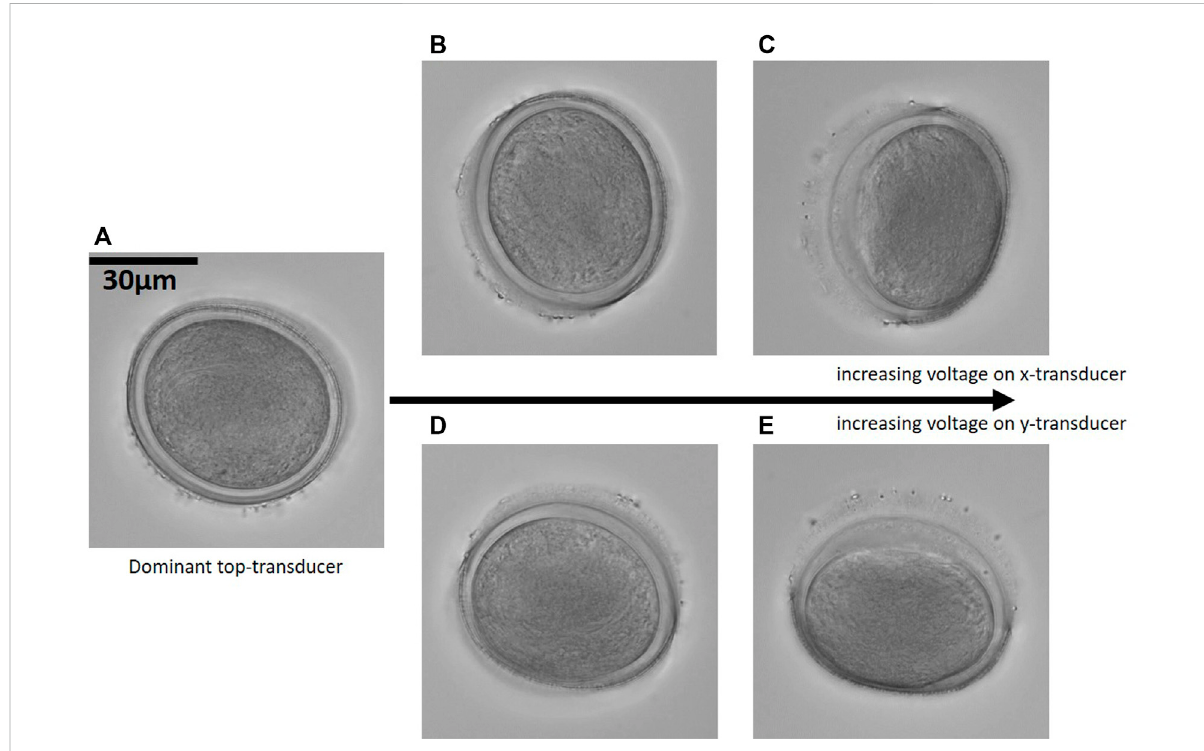
FIGURE 4 Transient reorientation: By adjusting the relative voltages of the three orthogonal transducers a pollen grain from Sansevieria trifasciata is transiently rotated. In (A) the particle aligns to the nodal planes from the top-transducer, in (B) and (C) the voltage on the x-transducer is increased and the particle aligns, within the top nodal plane, to an orientation up towards 90 ° relative to the orientation in (A) . (D,E) shows the particle orientation due to an increased voltage on the y-transducer. (40× magni fi cation, NA obj = 1.15 and NA con = 0.6). Corresponding Supplementary Movies S1,